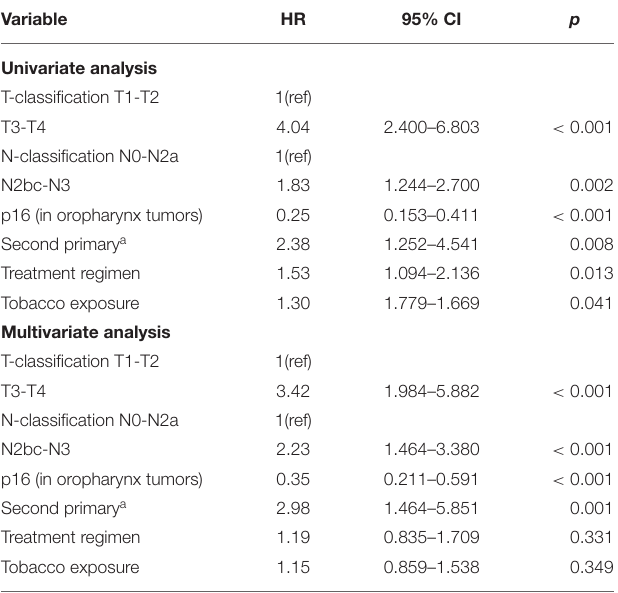
TABLE 5 | Significant Variables Univariate Analysis and Multivariate Analysis for Overall Survival.